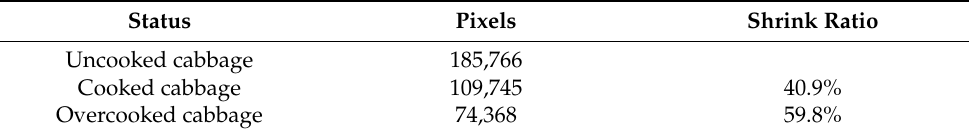
Table 1. The number of vegetables and the shrinkage ratio of cabbage in different cooking stages.